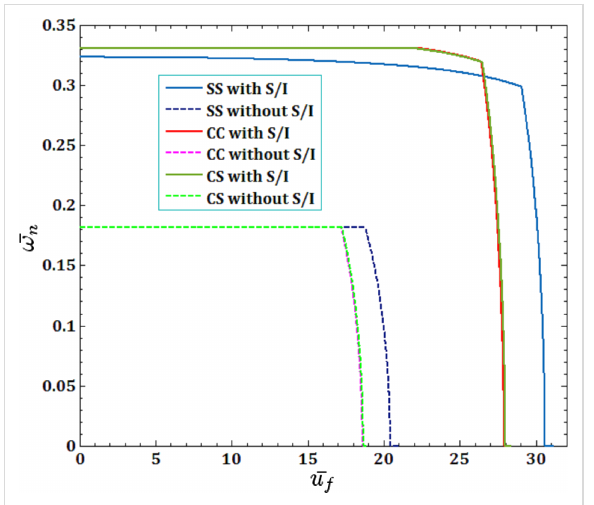
Figure 3: The effects of different boundary conditions for fluid velocity on DNF of FC-MWPENS.